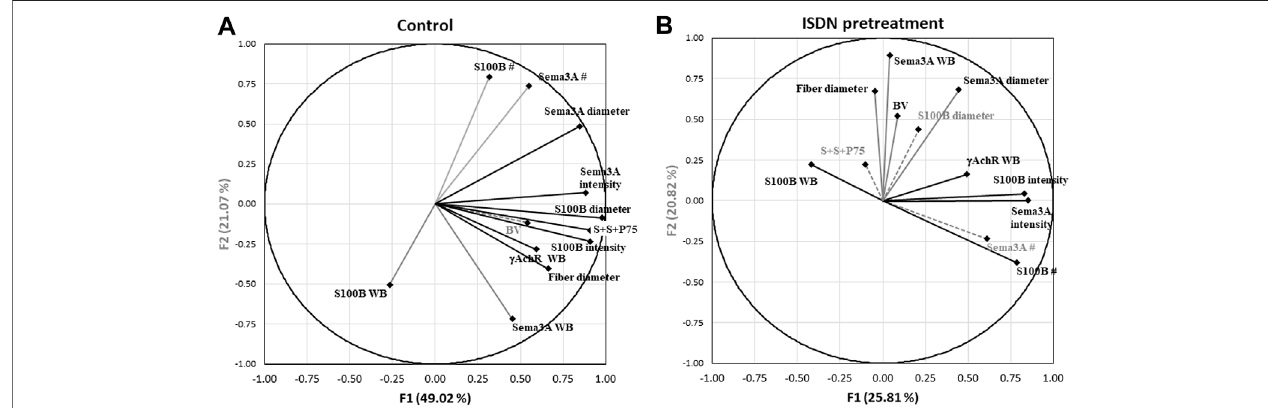
FIGURE 7| Principal component analysis (PCA) correlation circles of control and ISDN-treated groups ofregenerating muscle. Factors F1 and F2 form the x and y axes of each PCA correlation circle, respectively. A third factor (F3) is on the z -axis, which extends upward from the x-y plane. PCA datasets included variables from analyses of in situ hybridization (ISH), ISH with immunostaining (S100B and Sema3A transcripts and P75 protein), fi ber diameter, and Western blotting (WB) assessmentsofS100B,Sema3Aand γ AchRproteinsfrombothmuscle-crush(CR)-andcardiotoxin(CTX)-injuredgroups.Thedirectionandlengthofthevectorfor eachvariablerepresenttherespectiveloadingcoef fi cientsofthatvariablewiththethreefactors,F1,F2,andF3,asorthogonalaxes.Theendpointpositionofeachvector on the x-y grid represents the loading (or correlation) score of data collected for that variable (here, including all injury and treatment groups) on each of the F1 and F2 in the PCA plot. The factor to which a particular variable loads most strongly is indicated as a black line (to F1), a gray line (to F2), and gray dashes (to F3). (A) Correlation circle for untreated control muscles regenerating from CR and CTX injury ( n = 12). (B) Correlation circle for muscles regenerating from CR and CTX injury after 2 days of pretreatment with ISDN ( n = 14). Vectors are labeled for each variable as follows: WB for Western blotting data; BV for blood vessel density; and S + S + P75 for the number of overlapping expression sites for all three, Sema3A and S100B mRNAs and P75 protein. Data for fi ber diameter, blood vessel number, and Western blotting were reported previously (Daneshvar et al., 2020). Tables 3 and 4 provide the loading coef fi cients of each variable in the correlation circles shown in (A,B) , respectively.